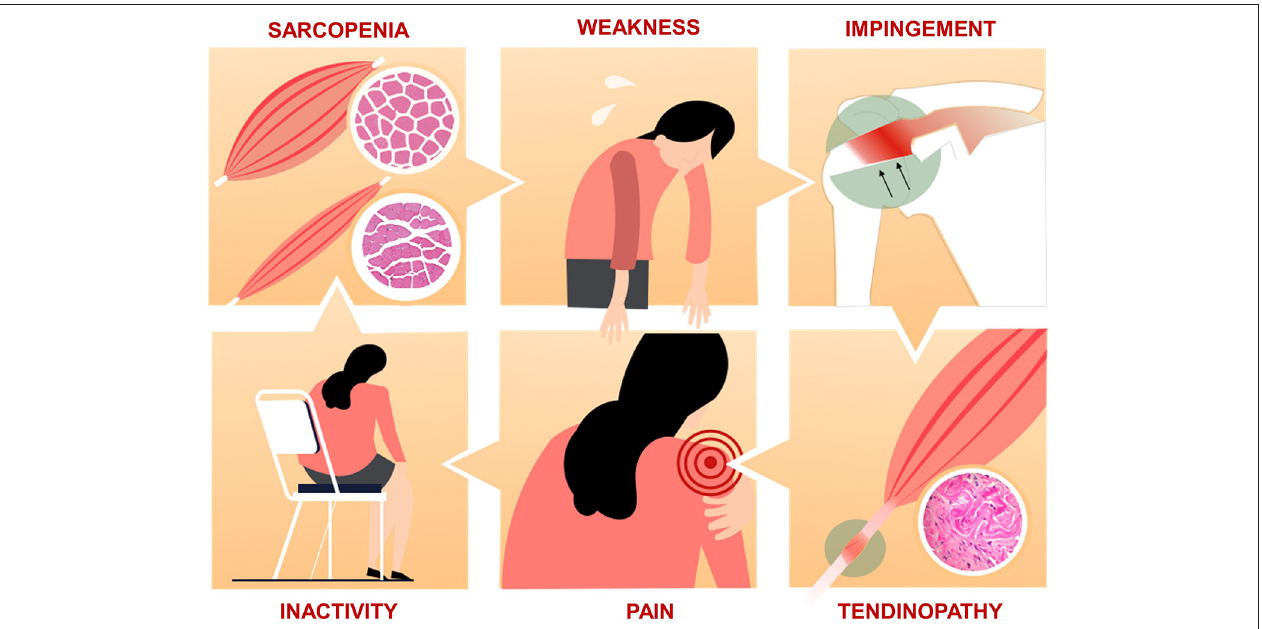
FIGURE 3 | A plausible diagram illustrating how sarcopenia interacts with rotator cuff tendon